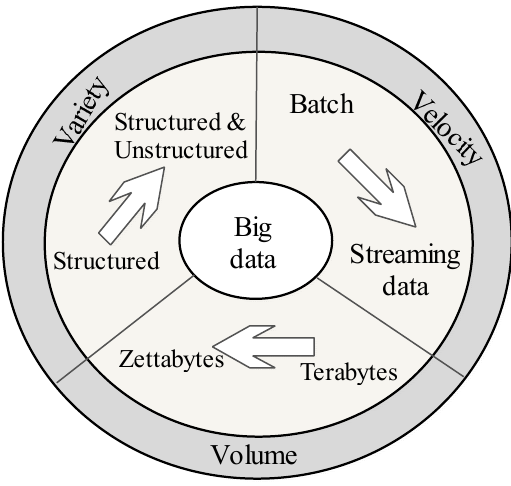
Figure 2. The Gartner’s Vector model .